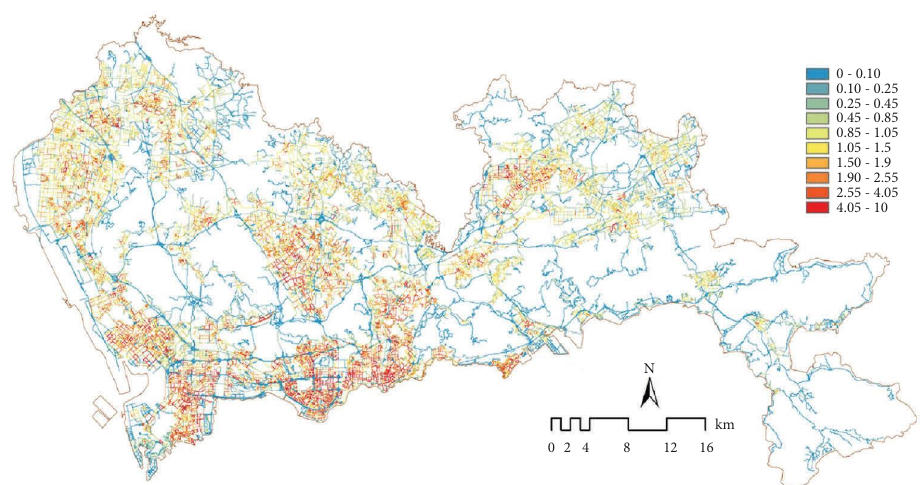
Figure 7: Development intensity of